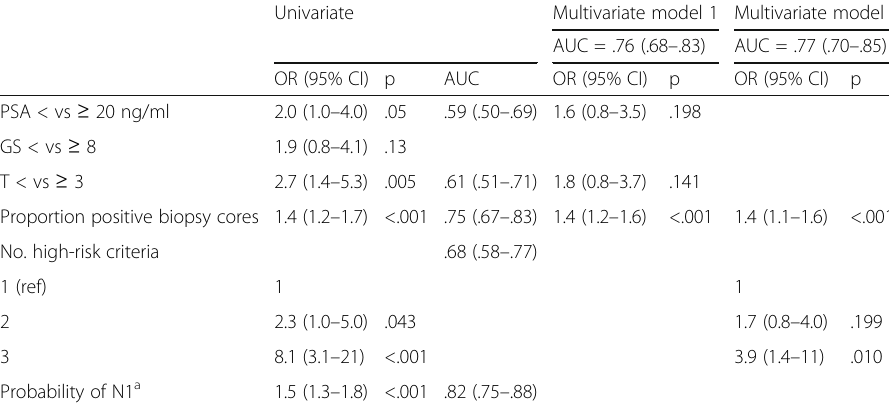
OR odds ratio, CI confidence interval, PSA prostate specific antigen, T clinical local tumor stage, AUC area-under-the-curve a Probability of lymph node metastases according to the Briganti nomogram (Briganti et al.,